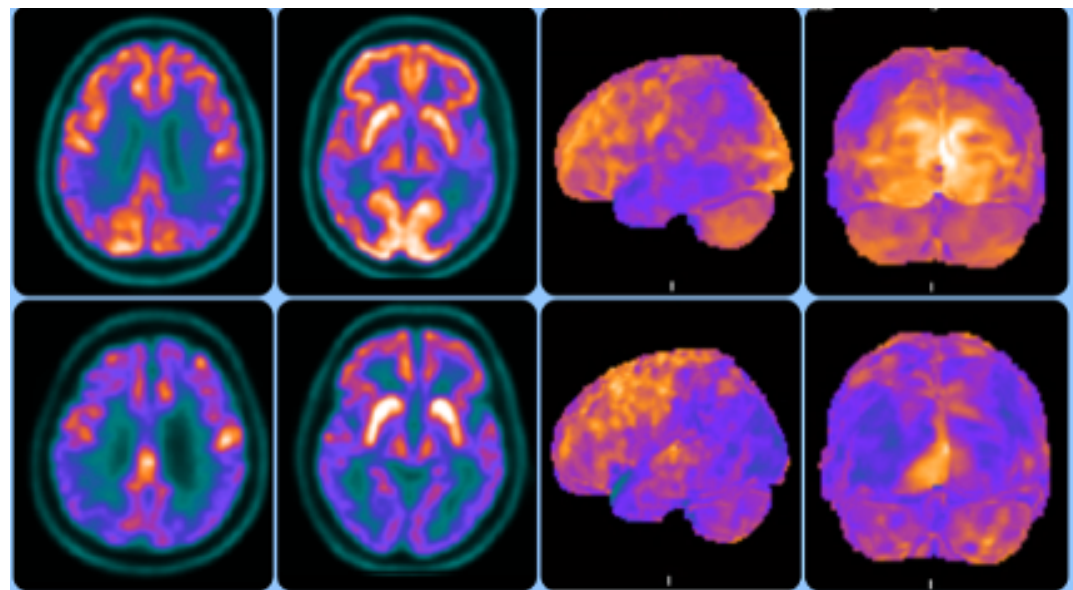
Figure 3. [ 18 F]FDG-PET images in Alzheimer’s disease (AD) and Dementia with Lewy Bodies